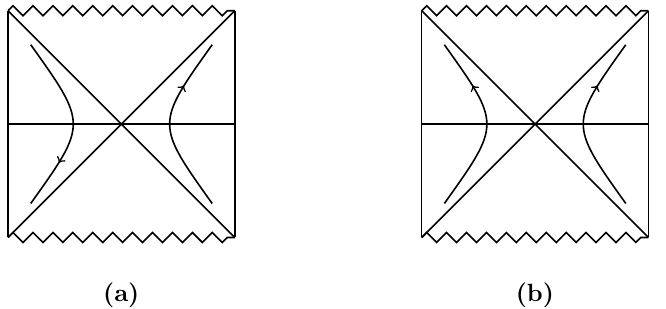
Figure 7. Two di(cid:11)erent interpretations of the extended AdS-Schwarzschild spacetime. Left: thermo(cid:12)eld description of one single black hole; the boost generated by the Hamiltonian propagates upward in the Right Exterior and downward in the Left Exterior. The opposite evolution direction in time implies the (cid:12)ctitious character of the Left Exterior. Right: two black holes in disconnected spaces with a common